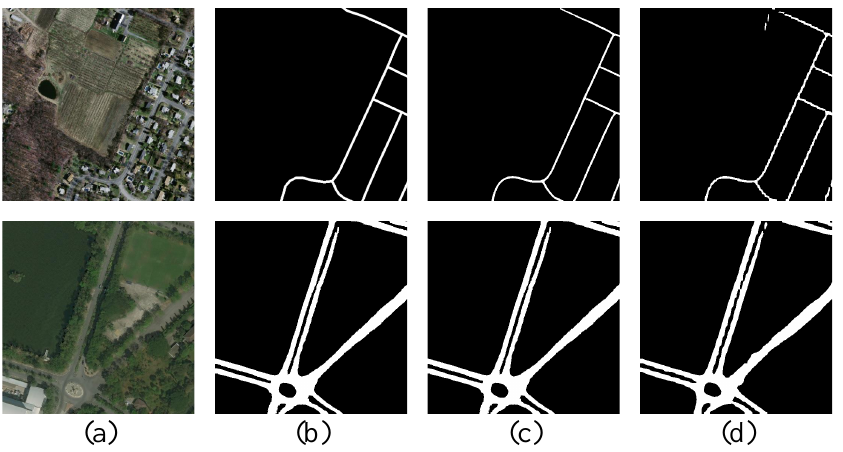
Figure 7. Comparison of our method with the visual segmentation results of CFPNet: the first row is the segmentation results of the Massachusetts Roads dataset; the second row is the segmentation result of DeepGlobe. ( a ) Original image. ( b ) Ground truth annotations. ( c ) Predicted results of CSANet. ( d ) Predicted results of